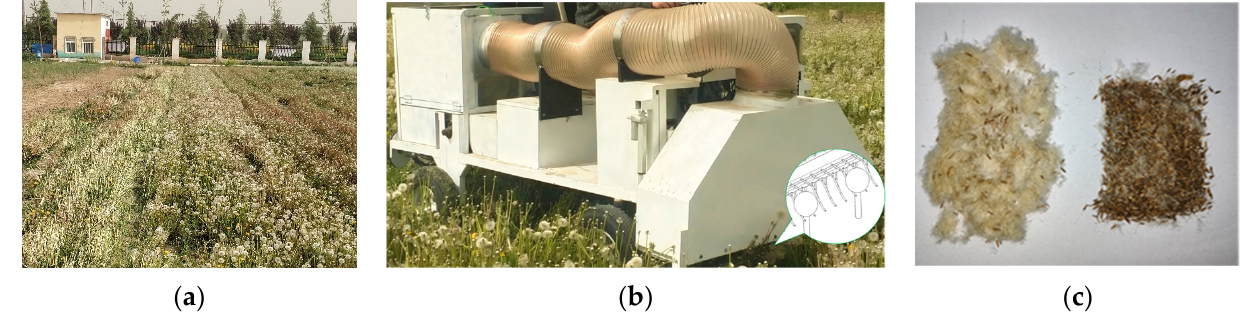
Figure 19. Harvester performance test. ( a ) Comparison diagram before and after harvest. ( b ) Har- vester operation diagram. ( c ) Separated seeds and crown hairs.